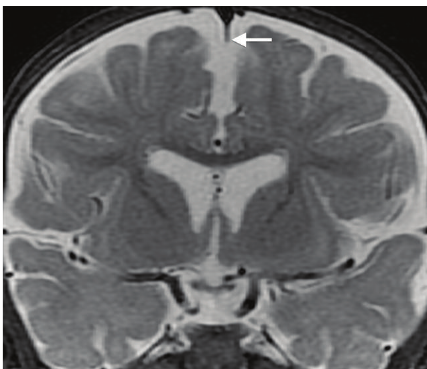
Figure 4: Coronal STIR (repetition time msec/echo time msec/in- version time msec, 4217/83/150) image demonstrating partial defi- ciency of the falx cerebri (arrow). Note the normal septum pellu- cidum.